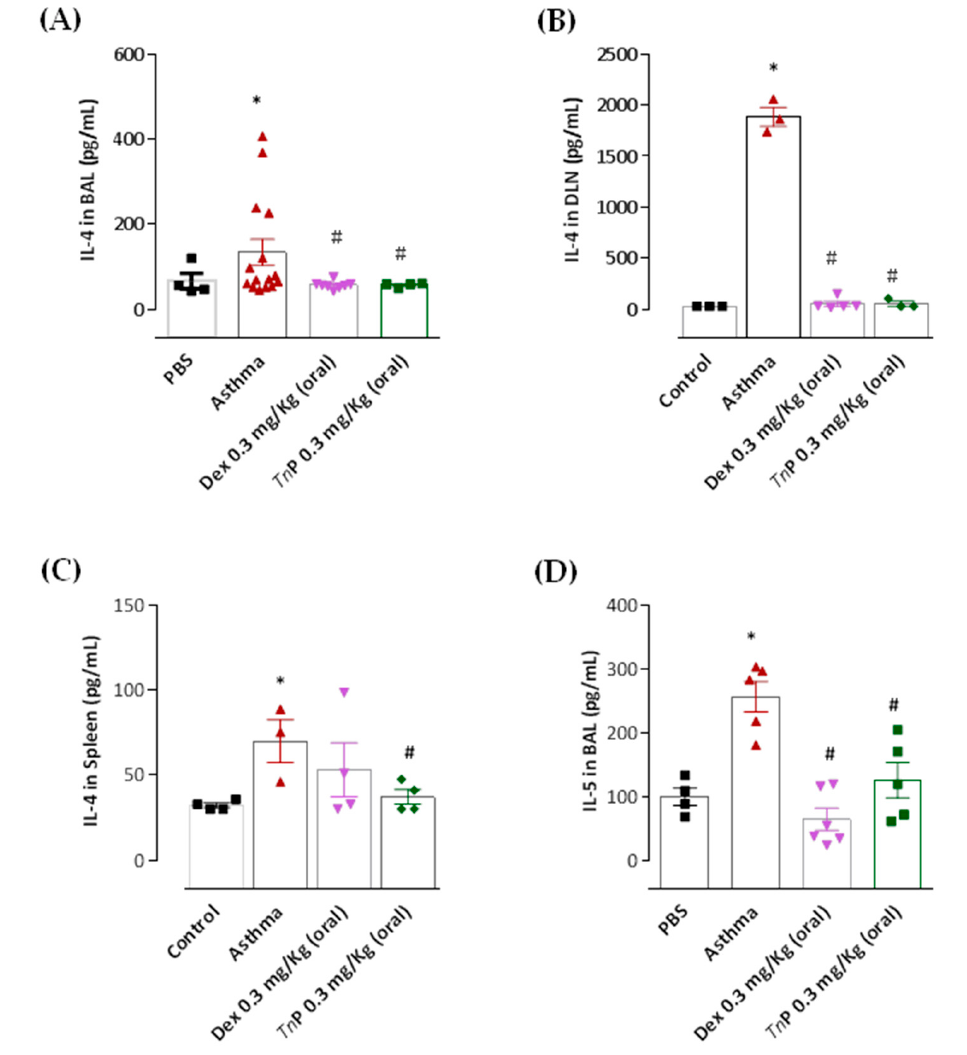
Figure 5. Tn P suppresses Th2 cytokine production. OVA-sensitized mice subjected to challenge with aerosolized OVA, submitted or not to treatment with Tn P or Dexa, were killed after 24 h for analysis of IL-4 in BAL ( A ), draining lymph node (DLN, B ), and spleen ( C ), and IL-5 in BAL ( D ) by cytokine-specific ELISA. * p < 0.05 compared to the control group and # p < 0.05 compared to the asthma group.